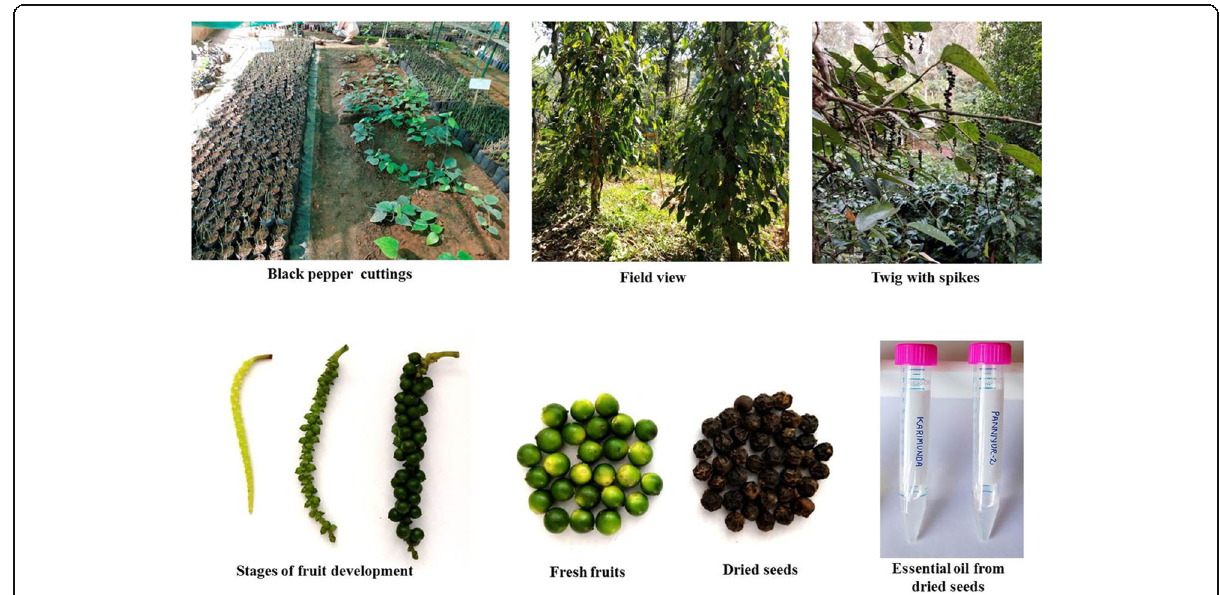
Fig. 1 Field view and botanical features of Black pepper ( P. nigrum